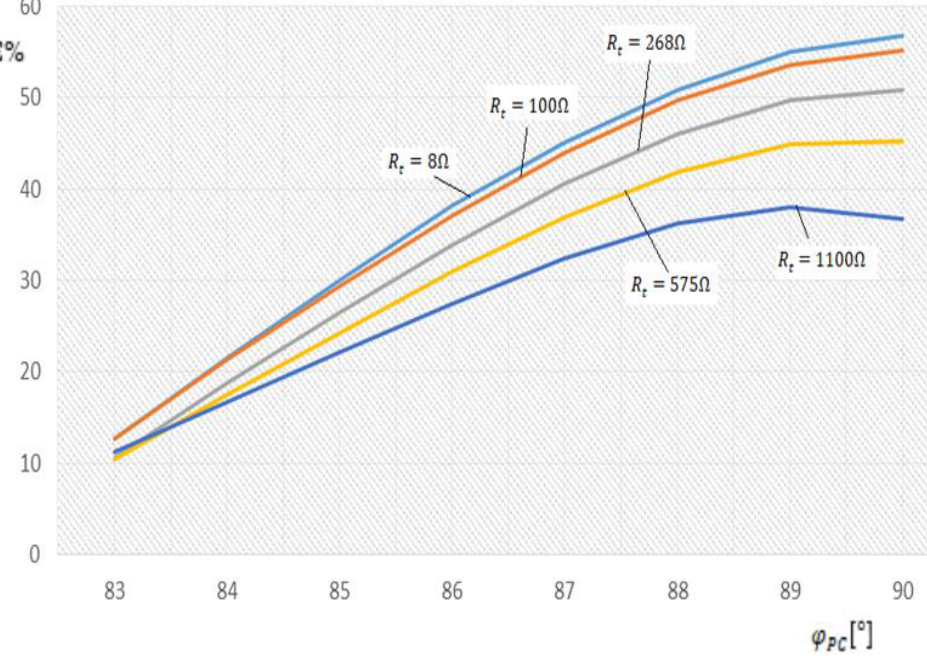
Figure 9. The dependence of difference between the effective values of the fault current, determined experimentally and analytically, and function on the difference phase between u PC and i PC , when ϕ c = 90 ◦